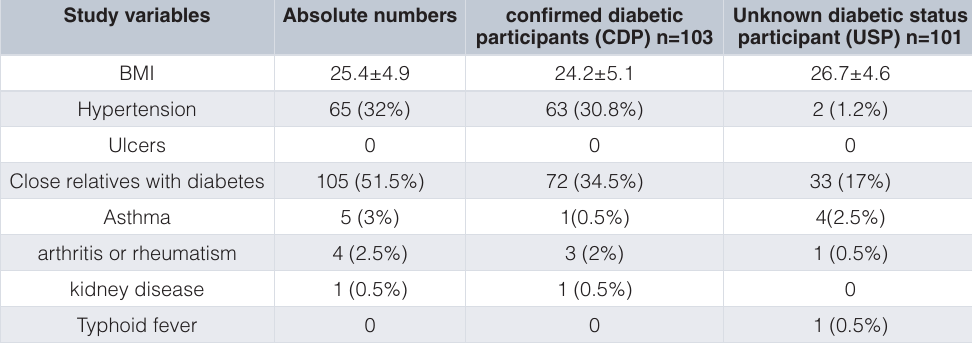
Table 2. Summary of study variables related to BMI and health conditions. demographic characteristics for the cohort. BMI is reported as means and standard deviations, (co-) occurrence of hypertension or close relative with diabetes, while diseases are reported in absolute values.